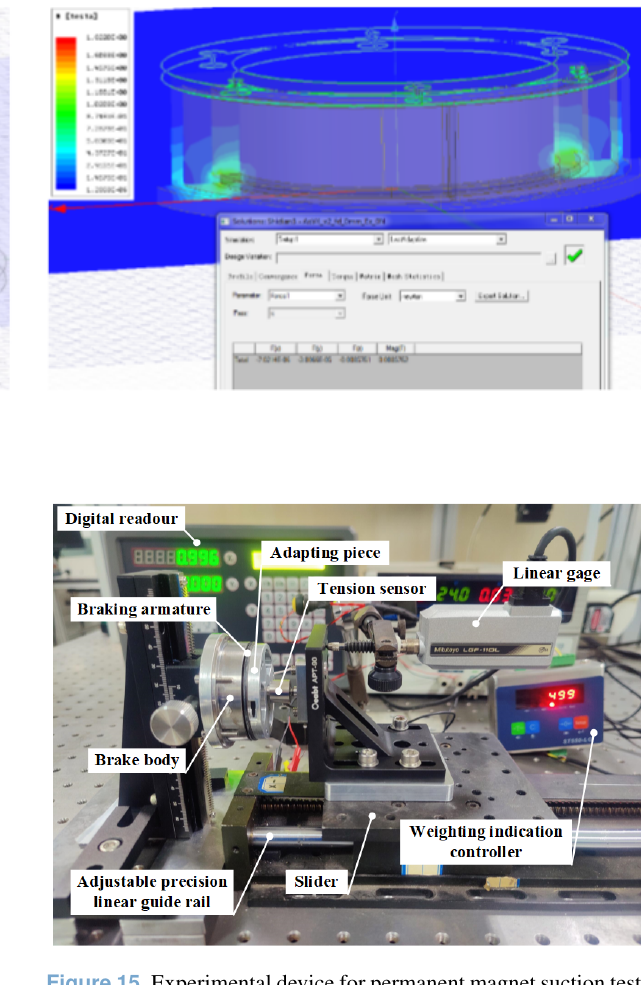
Figure 13. Experimental device for stiffness testing.